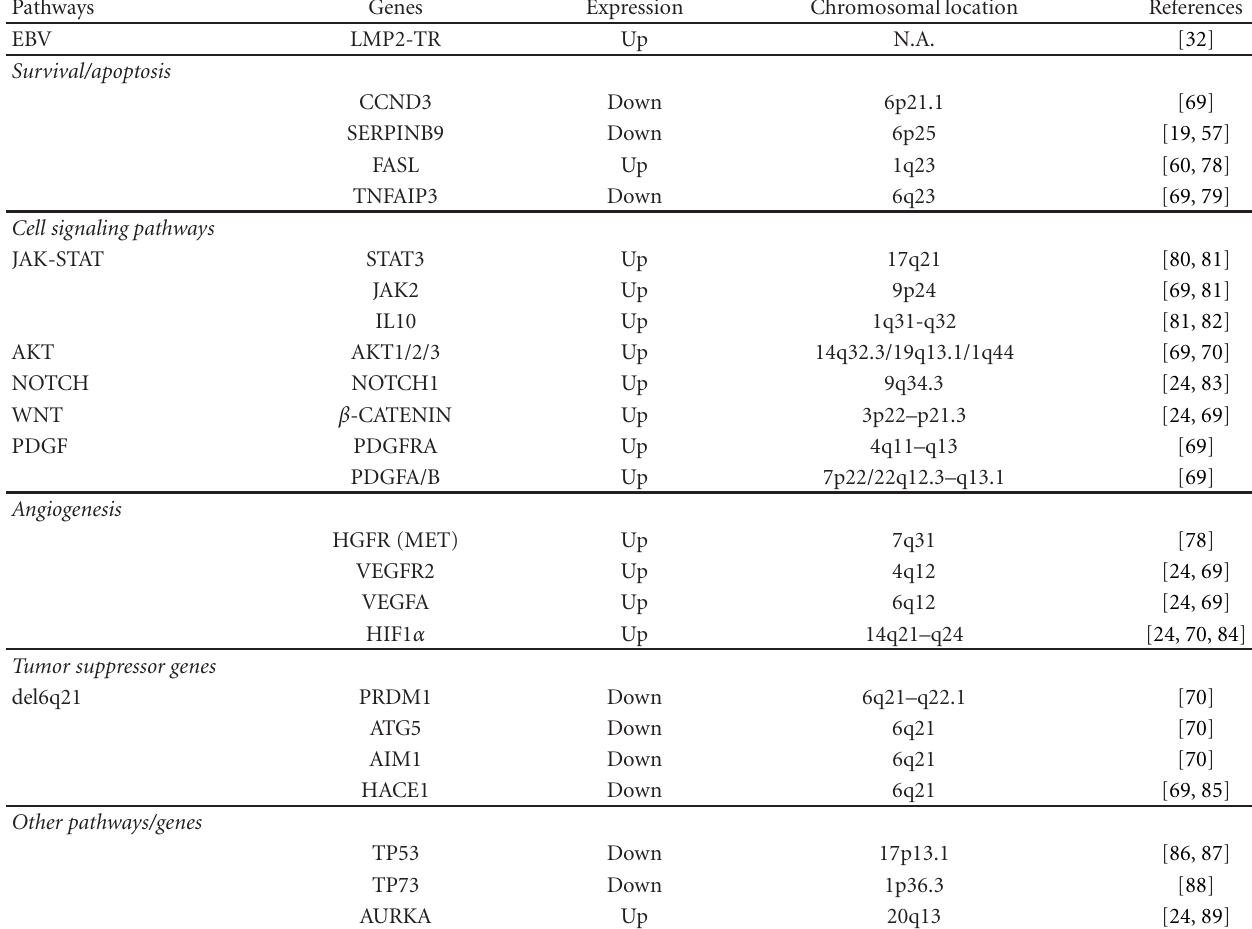
Table 2: Potential Therapeutic targets for extranodal